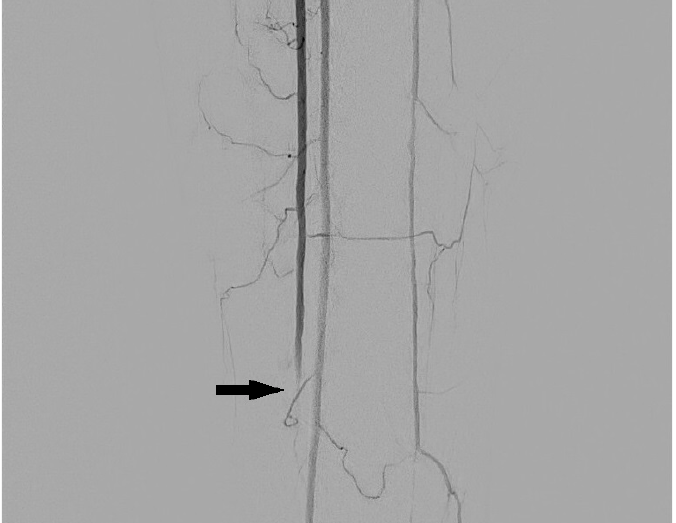
Figure 6. Acute occlusion of distal anterior tibial artery due to popliteal plaque embolization (black arrow).